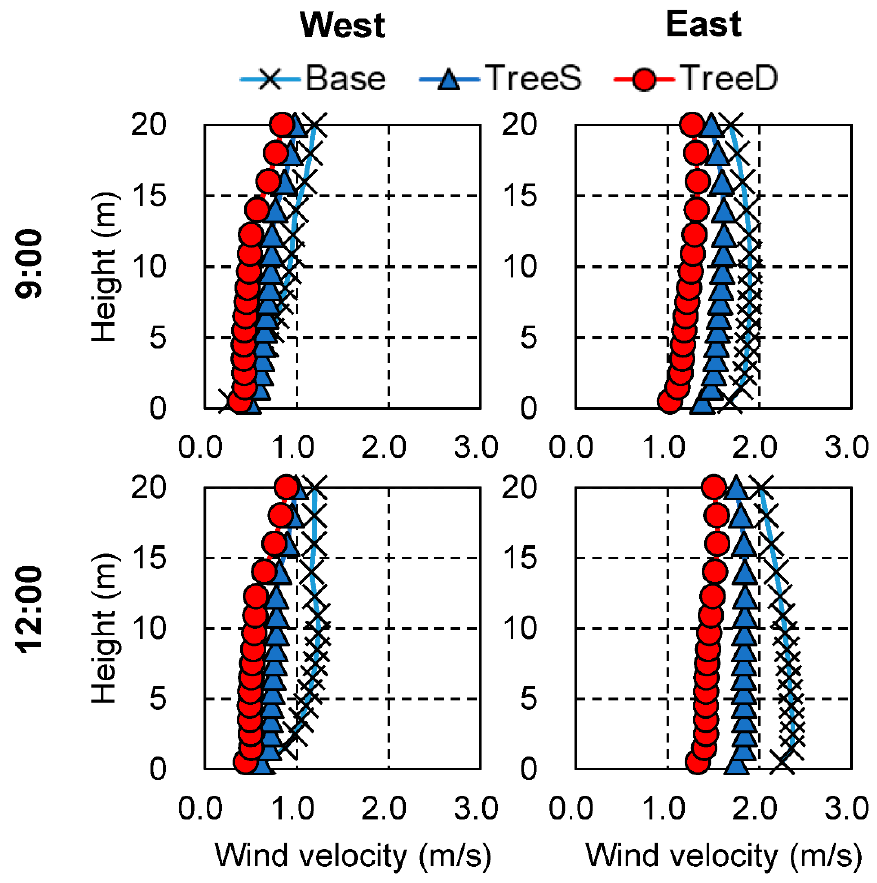
Figure 11. Vertical profiles of wind velocity that were spatially averaged in the y-direction in the analysis domain at 9:00 and 12:00 for each case.